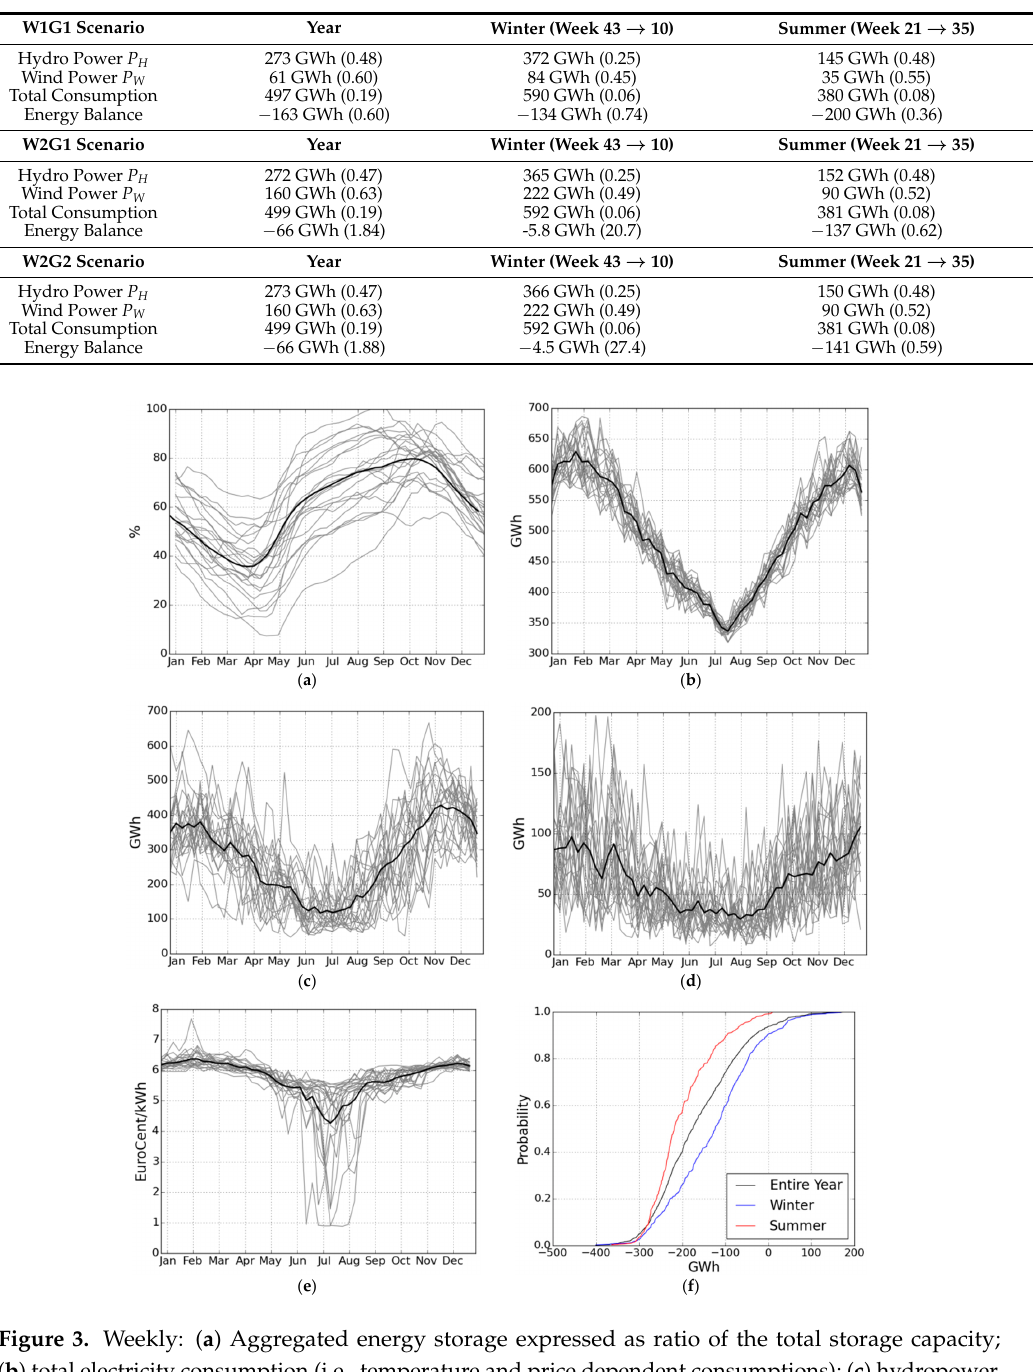
Table 2. Average yearly, winter and summer Mid-Norway weekly energy balance components for W1G1, W2G1 and W2G2 scenarios and for the control period 1961–1982. Number within brackets give coefficient of variation (CV, defined as the ratio between the standard deviation and the mean).